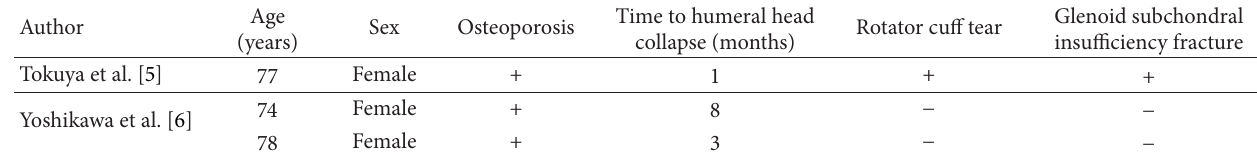
Table 1: Literature review of shoulder rapidly destructive arthritis.